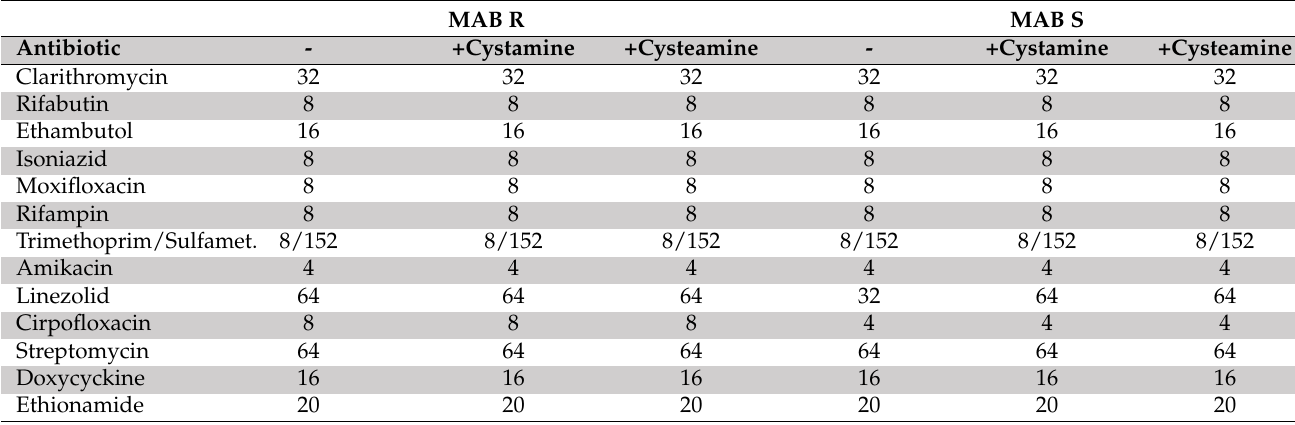
Table 1. MIC determination * of the two M. abscessus variants, MAB R and MAB S, against a panel of antibiotics, in the presence or not of cystamine (400 µ M) and cysteamine (800 µ M). MIC are expressed as µ